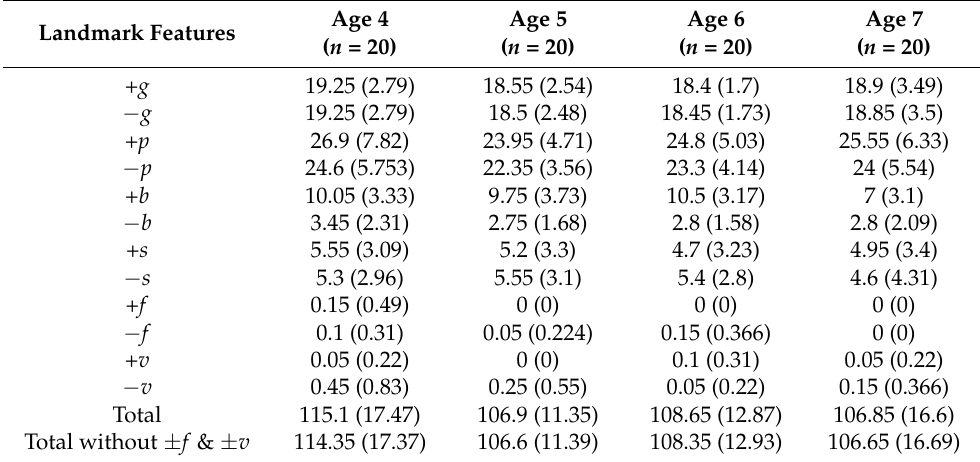
Table 3. Mean and standard deviation (in parentheses) of the landmark features produced by each age group. Landmark Features